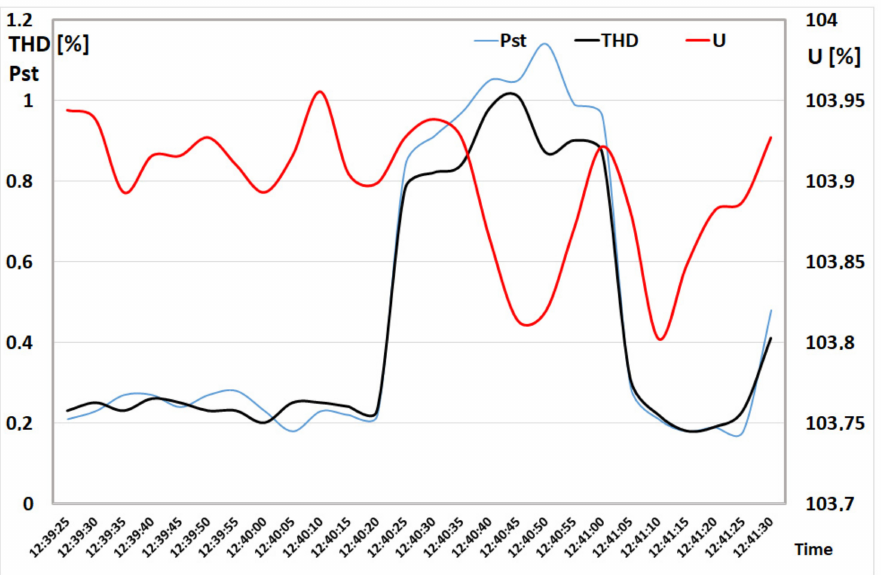
Figure 17. Short-term flicker P st , voltage and THD measured in line supplying the substation during starting process of the train—point